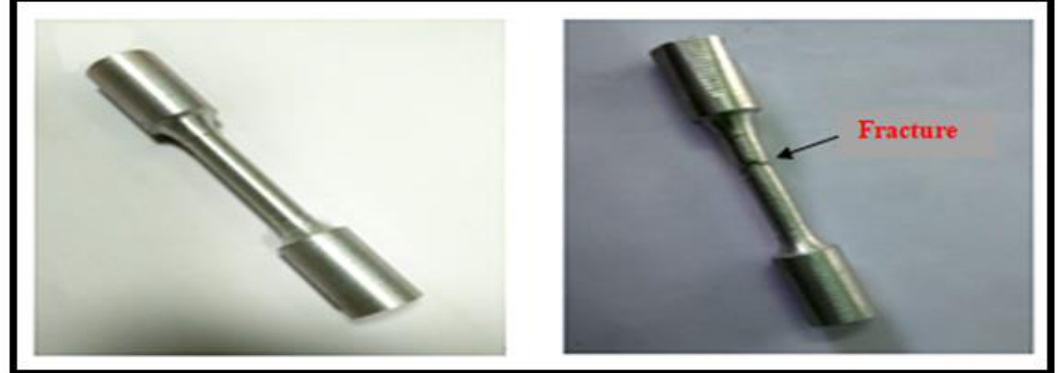
Figure 9. Tensile specimen before and after